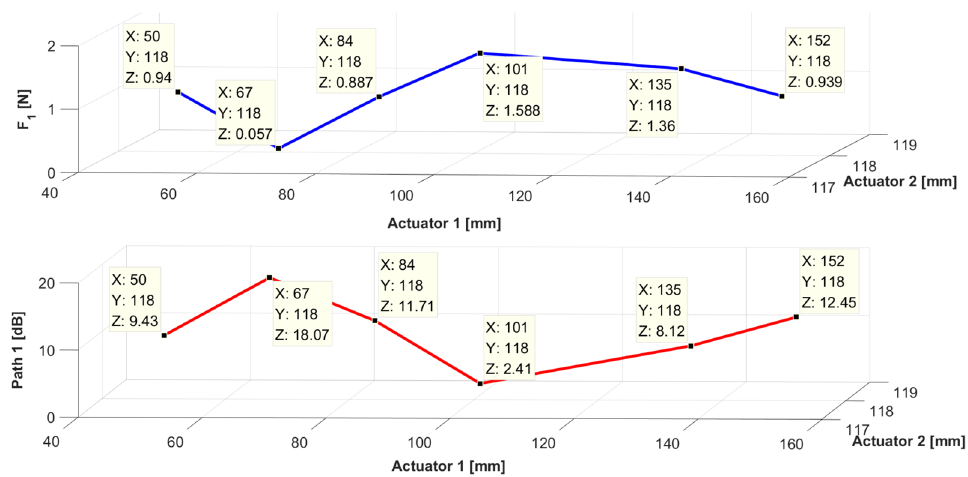
Figure 23. Compared magnitude with displacement for sinusoids at path 1. Key: blue line = control force; red line = vibration